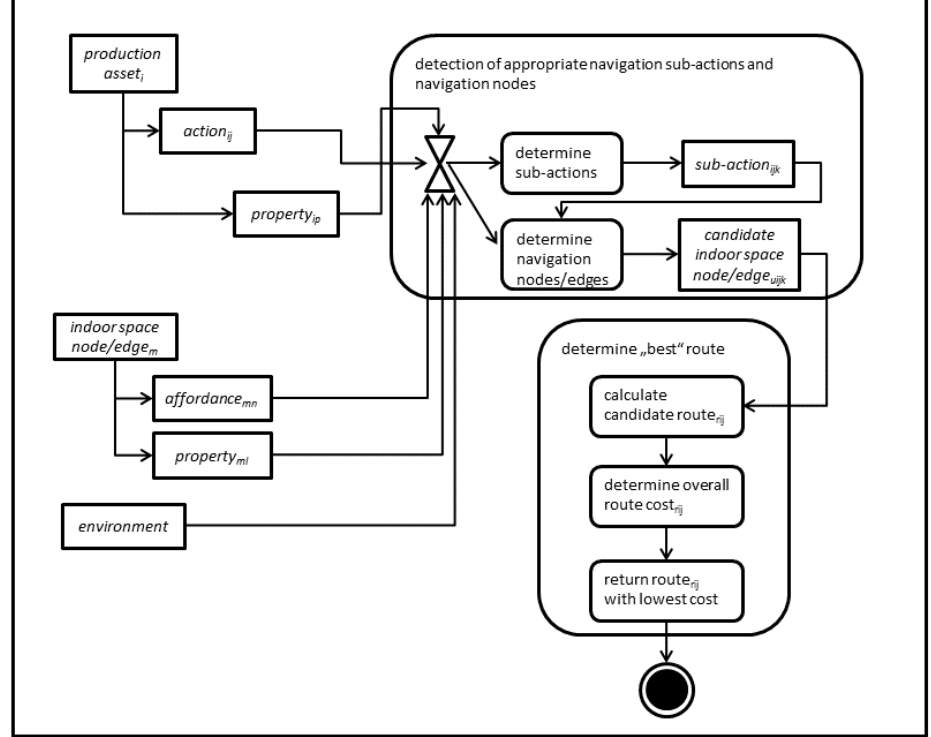
Figure 3. Approach to calculate the suitability of possible routes in an indoor environment, based on affordances (from